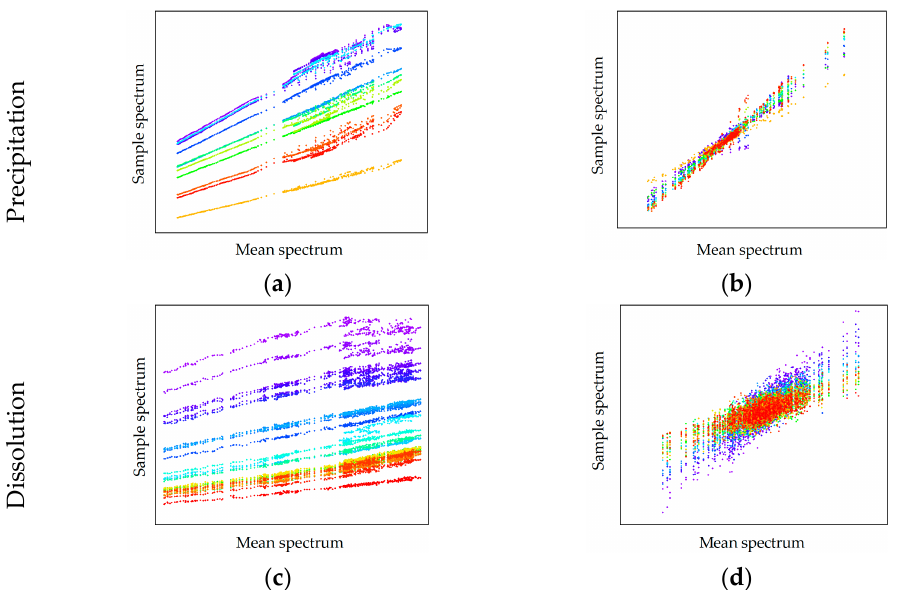
Figure 8. Raman scatter effects plot for evaluation of needed preprocessing of spectral data. ( a , c ) Show scatter effects of raw spectral data and ( b , d ) show scatter effects after preprocessing. The sample order is sorted from red to blue.